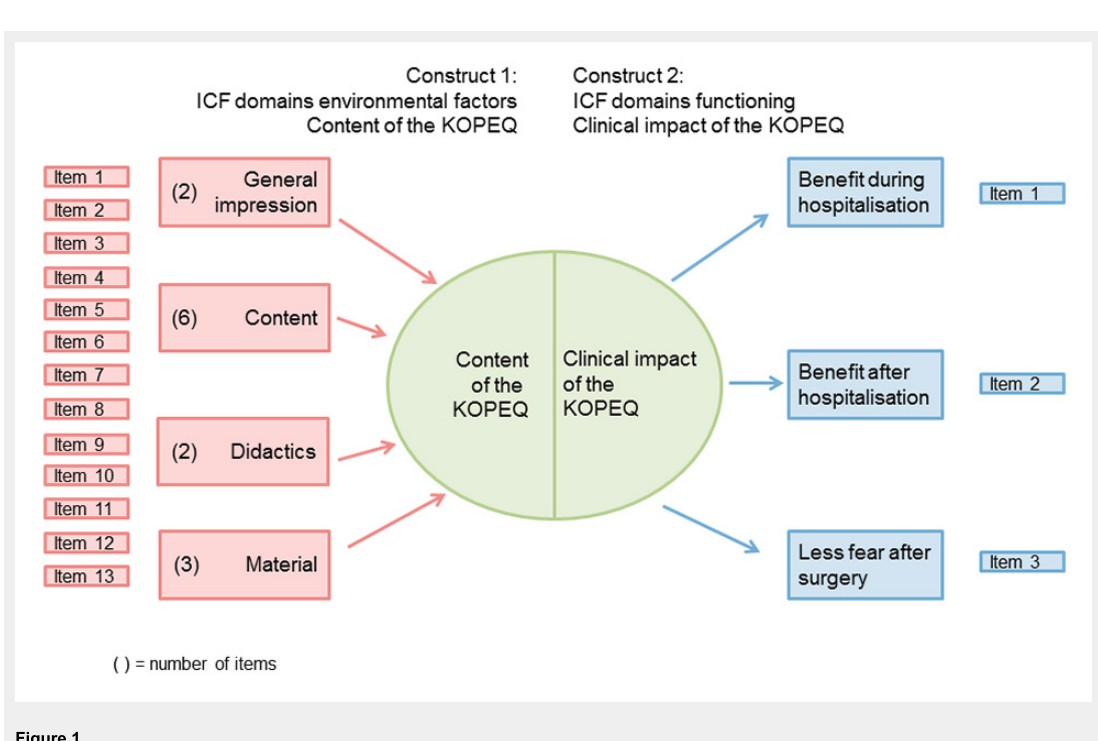
Figure 1 Conceptual framework of the Knee Osteoarthritis Patient Education Questionnaire (KOPEQ). ICF = International Classification of Functioning, Disability and